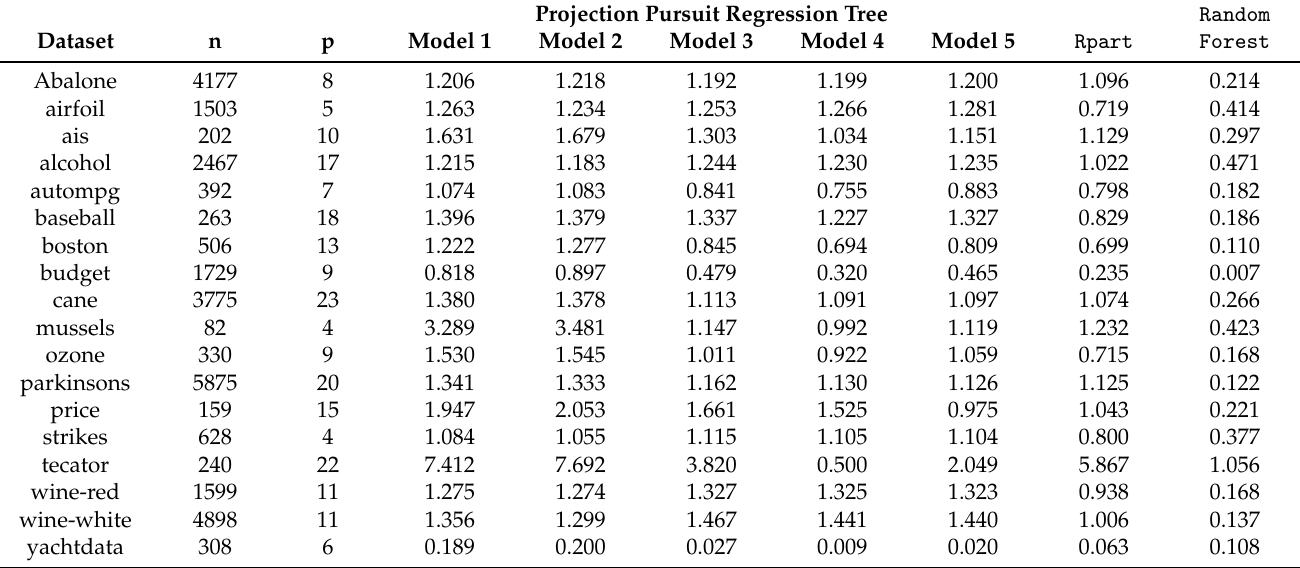
Table 7. Comparison of lm , rpart , randomForest , and the projection pursuit regression tree with various data sets; the mean MSE/MSE( lm )of 200 iterations for the training dataset.